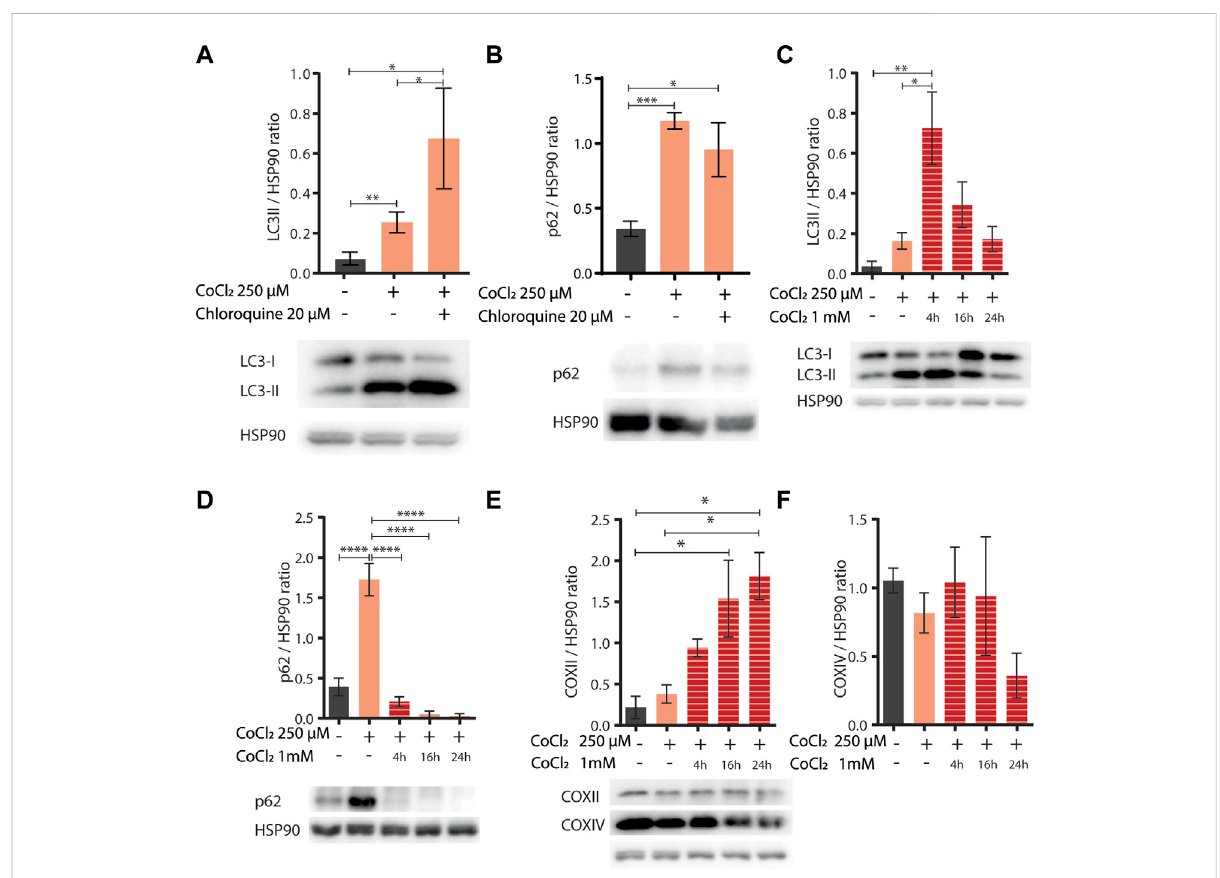
FIGURE 5 (A,B) WesternblotanalysisofLC3II (A) andp62 (B) proteinsextractedfromHeLacellsleftuntreated( − )ortreated(+)with250 µMofCoCl 2 alone or in combination with 20 µM of chloroquine. Proteins were normalized using HSP90; below the bar graph are shown the representatives Western blot scan. Bar graphs represent means ± SD (N = 3), two-way ANOVA (Tukey ’ s multiple comparison test). * p value < 0.05 and ** p value < 0.01. (C – F) Western blot analysis of LC3II (C) , p62 (D) , and COXII (E) and COXIV (F) proteins extracted from HeLa cells left untreated ( − ) or treated (+) with 250 µM ofCoCl 2 aloneor incombination with 1 mM ofCoCl 2 atdifferentexposure time 4,16,and 24 h. ProteinswerenormalizedusingHSP90, and below the bar graph (C – E) are shown the representatives Western blot scan. Bar graph represents means ± SD (N = 3), two-way ANOVA (Tukey ’